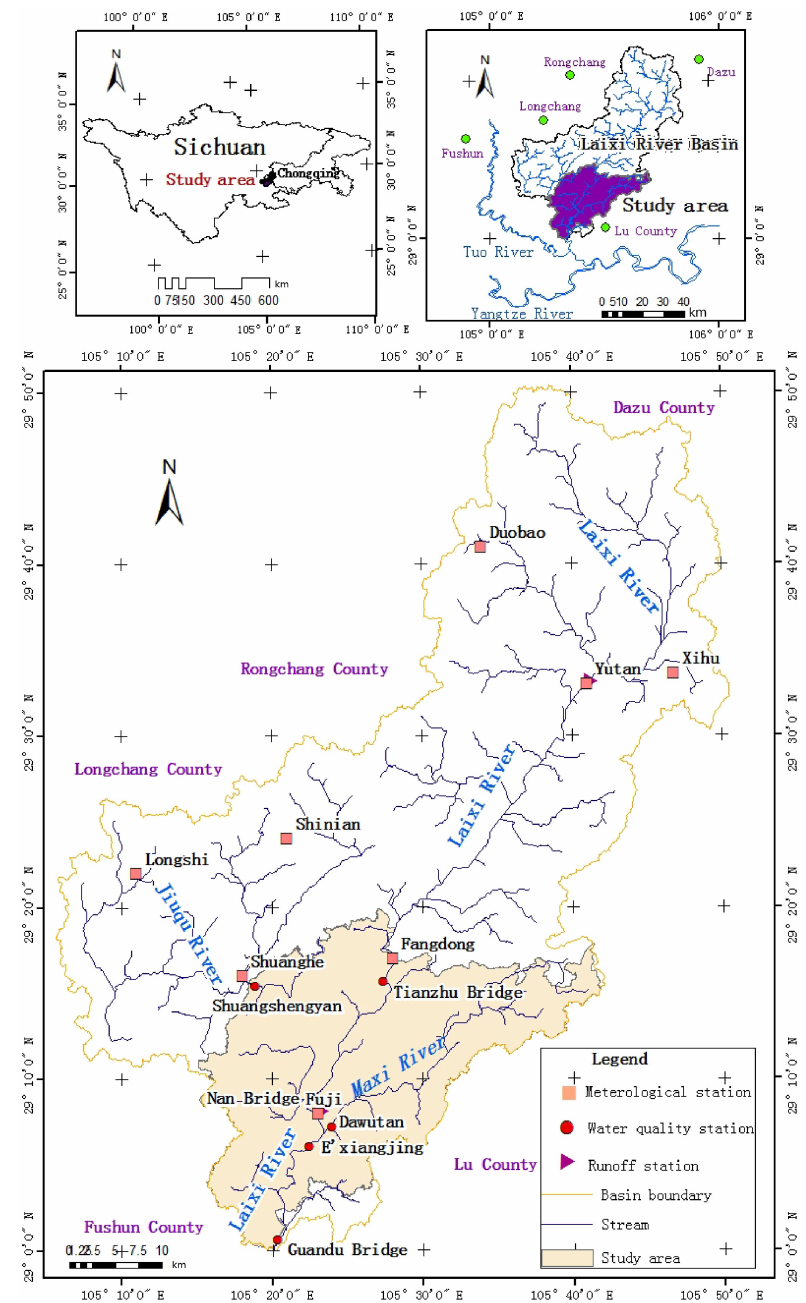
Figure 2. Study area and the spatial distribution of hydrological, meteorological, and water quality stations.